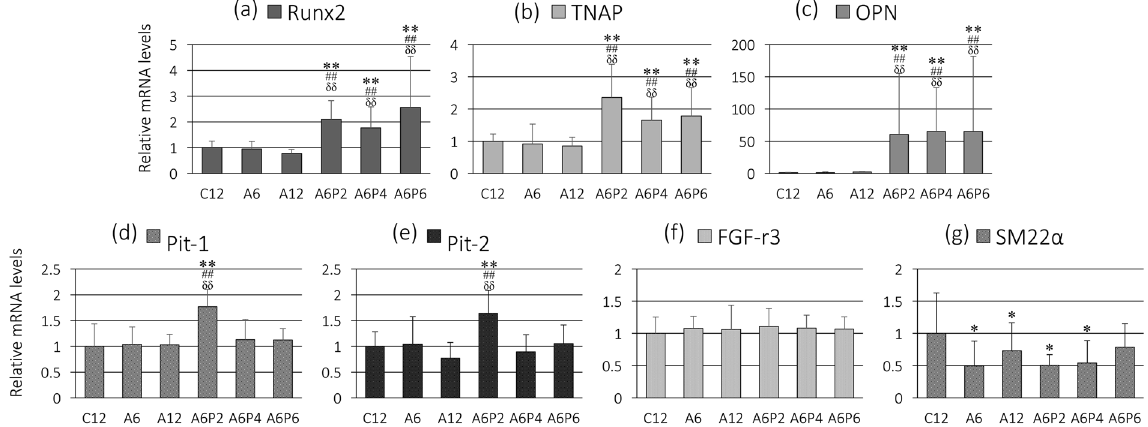
Figure 5. Quantitative real-time RT-PCR analysis of aortic tissue. Levels of Runx2 ( a ), tissue non-specific alkaline phosphatase (TNAP) ( b ), osteopontin (OPN) ( c ), Pit-1 ( d ), Pit-2 ( e ), fibroblast growth factor receptor 3 (FGF-r3) ( f ), and SM22- α ( g ) mRNA were determined by quantitative real-time PCR in triplicate and normalized to 18S rRNA levels. The data are represented as the mean ± SEM (n = 5); * P < 0.05 and ** P < 0.01 versus C12; ## P < 0.01 versus A6; δδ P < 0.01 versus A12; all P -values are evaluated by non-repeated measures